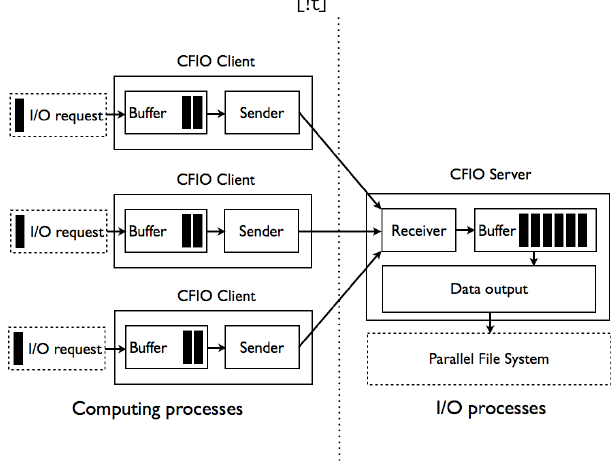
Fig. 3. The system architecture of